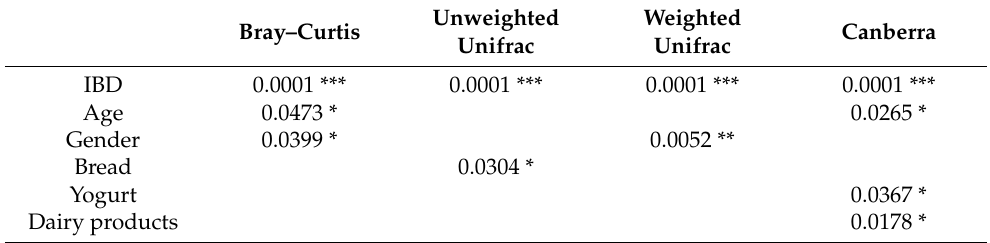
Table 1. Regression PERMANOVA using four metrics to evaluate the β -diversity and identify microbiota shaping variables using a stepwise regression through manual backward elimina- tion. The symbols indicate the p -value threshold (‘’*”: p -value ≤ 0.05, “**”: p -value ≤ 0.01 and “***”: p -value ≤